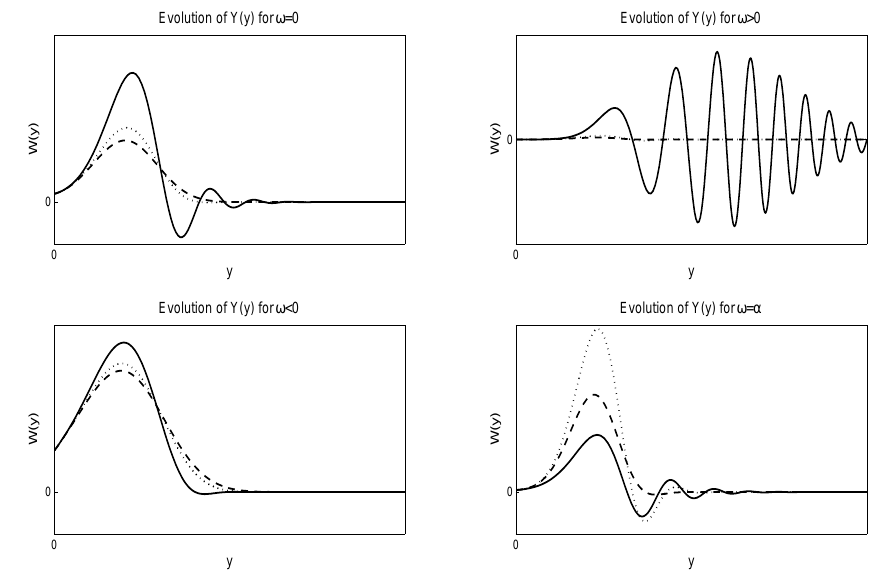
Figure 3. Evolution of the solution Equation (56) of the Stein–Stein model. For the numerical solutions, we select β = 0.5, r = 0.5, κ 1 = 1 and κ 2 = 0.5. The figures are for ω = 0, ω = 0.5, ω = − 0.5 and ω = α , respectively. The solid lines are for α = 0.1, the dotted lines are for α = 0.3 and the dash-dash lines are for α =